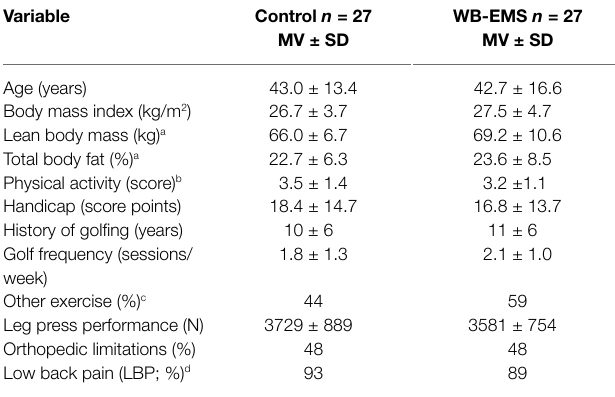
TABLE 1 | Baseline characteristics of the control group and WB-EMS group.